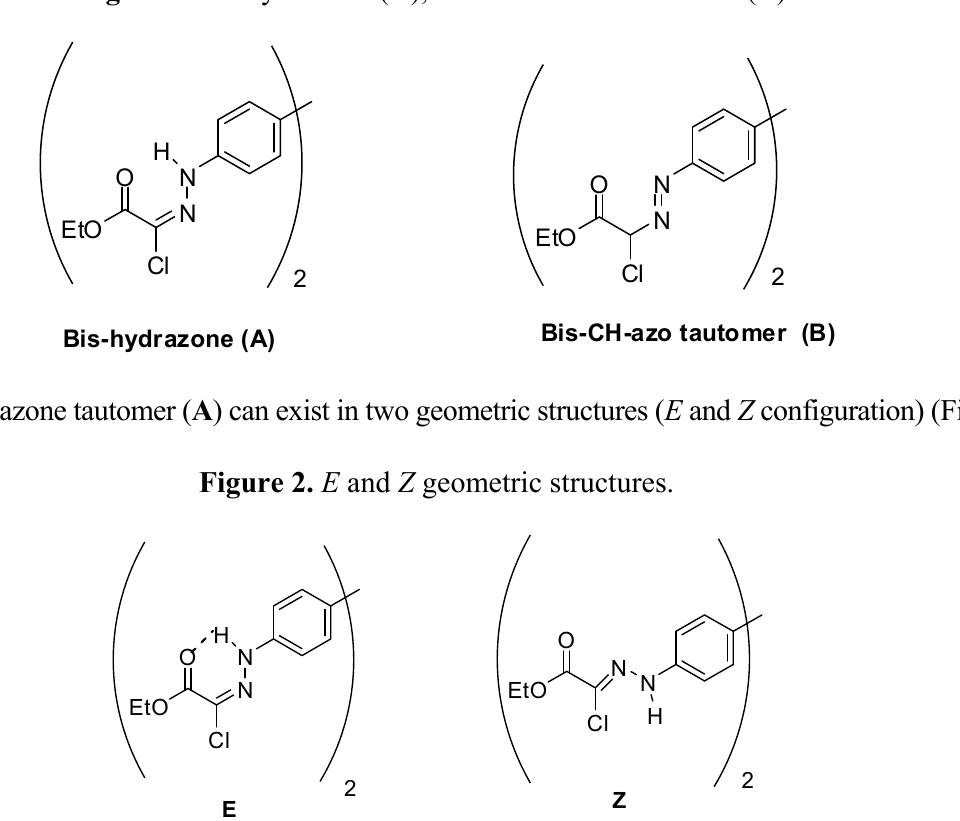
Figure 1. bis -hydrazone ( A ), and bis -CH-azo tautomer ( B ).